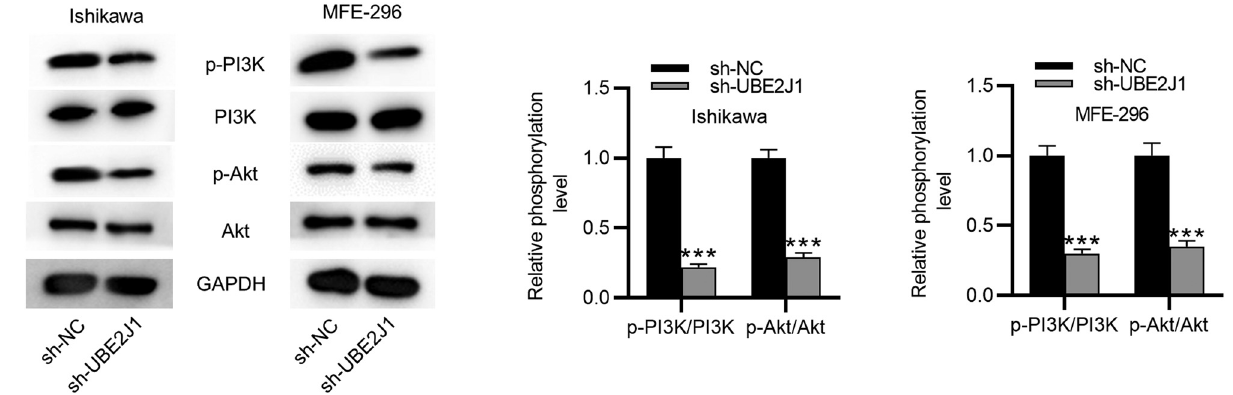
Figure 3: UBE2J1 downregulation inhibits the PI3K/AKT signaling pathway. Western blot analyses were used to detect the protein levels of key molecules involved in the PI3K/AKT signaling pathway in EC cells after downregulating UBE2J1. Bar graphs were used to represent the data. *** p < 0.001.